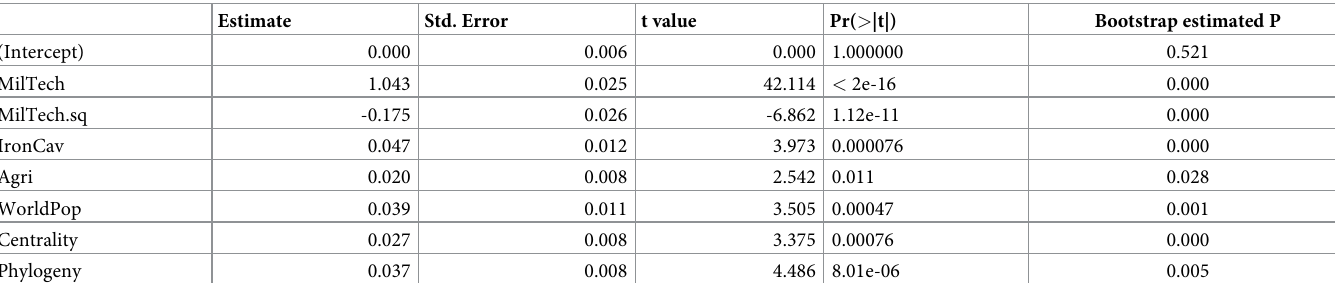
Table 1. Regression results for the best (lowest AIC) regression